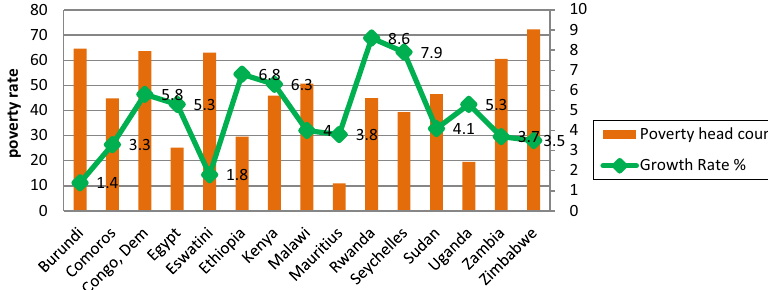
Figure 1. Growth and poverty